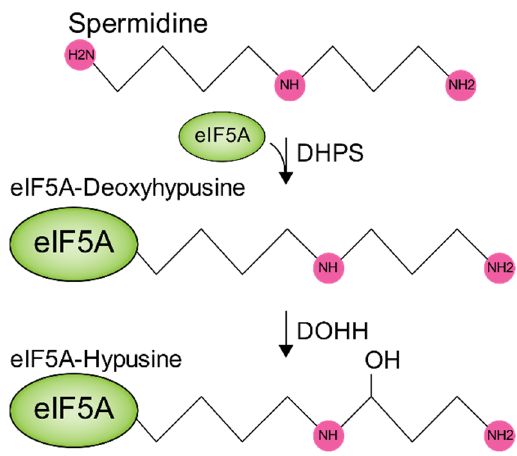
Figure 3. The mammalian eIF5A hypusination pathway. Spermidine is conjugated to eukaryotic initiation factor 5A (eIF5A) by the action of deoxyhypusine synthase (DHPS) to form eIF5A-deoxyhypusine, which is deacetylated by deoxyhypusine hydroxylase (DOHH) to form eIF5A-hypusine.